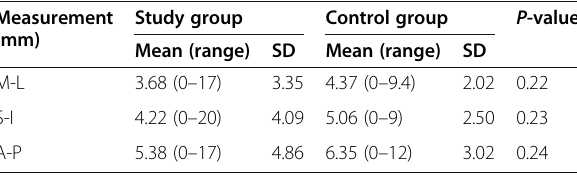
Table 2 Differences between the position of right and left gonions in different dimensions Measurement Study group Control group P -value (mm) Mean (range) SD Mean (range)